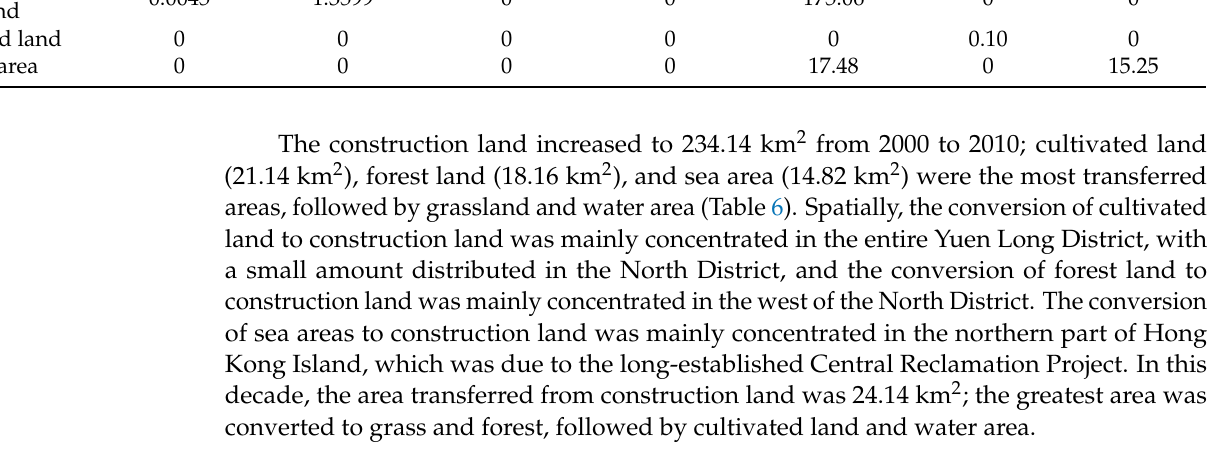
Table 6. Land use conversion matrix, 2000–2010 (km 2